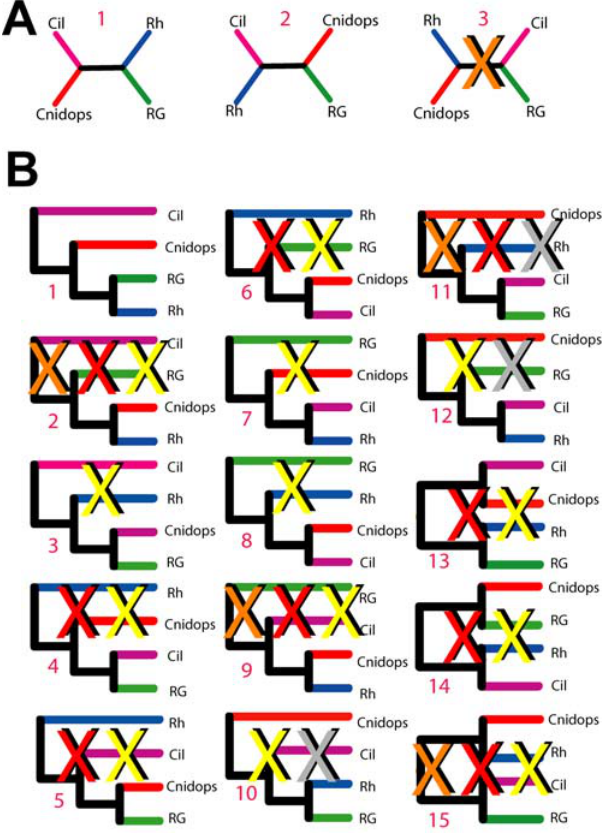
Figure 3. Summary of analyses to determine and root opsin phylogeny. Illustrated is each possible unrooted and rooted hypoth- esis, assuming monophyly of four major opsin clades. Trees in (A) 1–3 correspond to possible unrooted topologyies and those in (B) 1–15 represent all possible rooted trees, see Table 1. Orange X indicates that tree had significantly lower likelihood in opsin-only dataset. Red X indicates tree had significantly lower likelihood in opsin + outgroup dataset. Yellow X indicates that tree implies additional gene duplica- tion/loss events compared to minimum (tree 1 is minimum with 2 duplications 0 losses implied). Grey X indicates tree with cnidops as earliest branching opsin group–a result inferred in parametric bootstrap analyses, which incorrectly grouped cnidops + outgroup opsins because of long branch-attraction (see supplementary methods). Cil=ciliary; Rh=rhabdomeric; RG=Go/RGR.